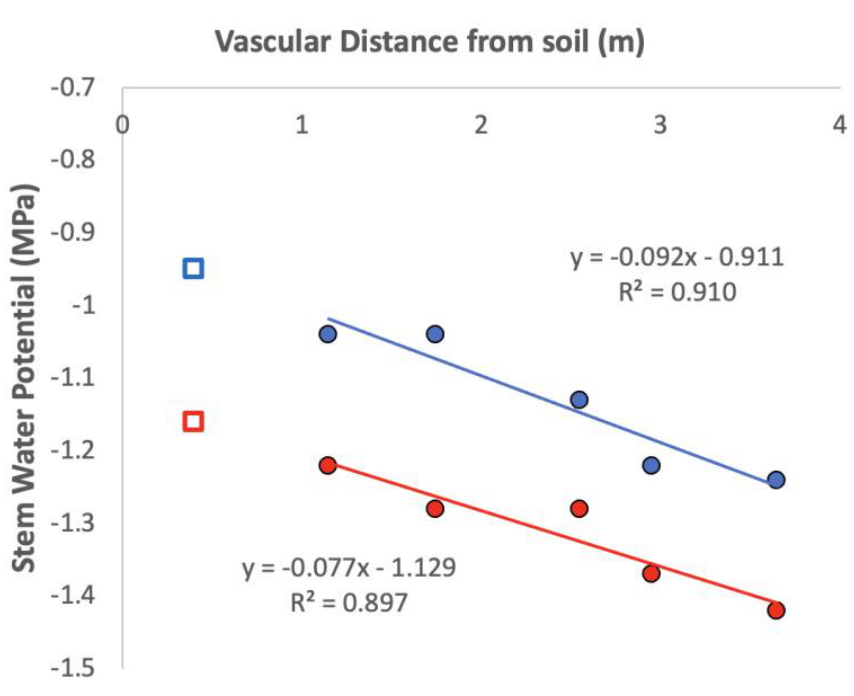
Figure 9. Changes in stem water potential by pressure chamber with vascular distance from the soil in a Gala tall spindle apple tree on two sunny days 4 days apart. The upper relation was found on a mild day (24 °C, 65% RH, 1 m s −1 wind), while the lower relation was found on a day with higher evaporative demand (27 °C, 43% RH, 3 m s −1 wind). The square symbol on each relation indicates the expected stem potential at 0.4 m; the microtensiometer location using the regressions for each day. Additionally, there can be very significant variation in pressure chamber readings due to operator variation in the many subtle techniques of leaf selection, handling before pressurizing, protective enclosures, rate of pressurization and determining endpoints [35,54]. Levin et al. [55] concluded that operator variation affected potential readings more than any specific technique of the method, which supports the extensive experience of the senior author. Nonetheless, the correlations with the SPC indicate